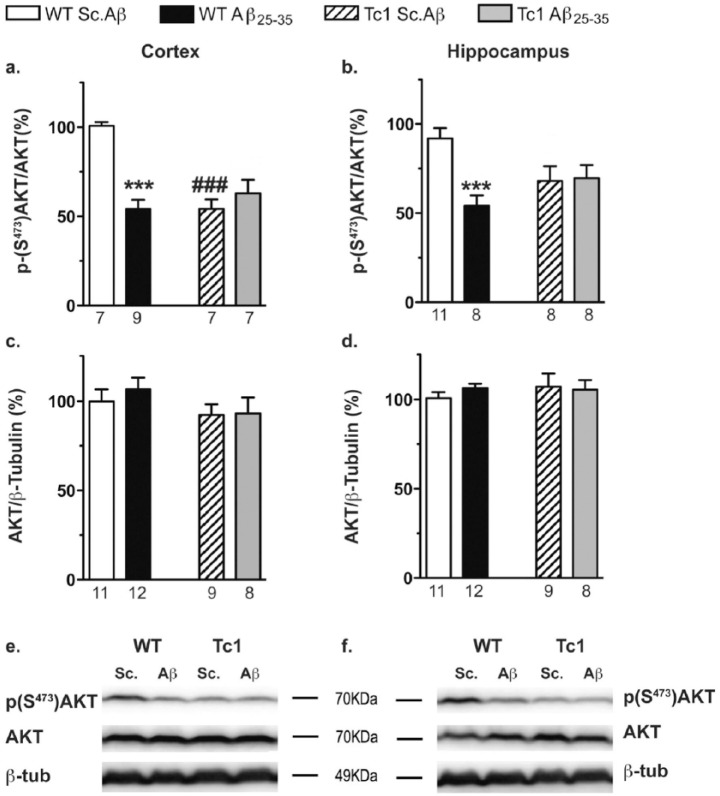
Phosphorylation of protein kinase B (AKT) at serine 473 in the cortex and hippocampus of Tc1 mice injected with amyloid-β [25-35] (Aβ25-35) peptide. Wildtype (WT) or Tc1 mice were administered intracerebroventricular (i.c.v.) injections with scrambled peptide (Sc.Aβ) or Aβ25-35 peptide (9 nmol) and sacrificed 10 days after injection. The abundance of AKT phosphorylated at serine 473 ((a) and (b)) and total AKT ((c) and (d)) was investigated by Western blot of total cortical ((a) and (c)) and hippocampal ((b) and (d)) protein lysates. Phospho-AKT signal was normalised to total AKT signal in each group. Typical blots are shown for the cortex (e) and the hippocampus (f). The number of animals per group is indicated below the columns. Two-way analysis of variance (ANOVA): F(1,26)=12.4, p<0.01 for the genotype, F(1,26)=12.4, p<0.01 for the treatment, F(1,26)=26.4, p<0.0001 for the interaction in (a); F(1,31)=0.385, p>0.05 for the genotype, F(1,31)=7.06, p<0.05 for the treatment, F(1,31)=8.29, p<0.01 for the interaction in (b); F(1,37)=2.22, p>0.05 for the genotype, F(1,37)=0.285, p>0.05 for the treatment, F(1,37)=0.172, p>0.05 for the interaction in (c); F(1,36)=0.371, p>0.05 for the genotype, F(1,36)=0.184, p>0.05 for the treatment, F(1,36)=0.604, p>0.05 for the interaction in (d). ***p<0.001 vs same genotype Sc.Aβ-treated mice; ###p<0.001 vs same treatment WT mice; Bonferroni’s test.